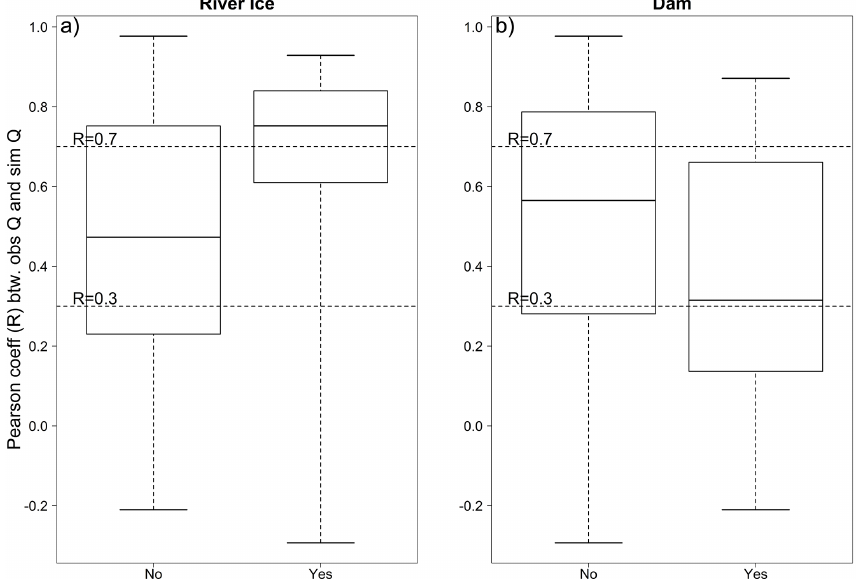
Figure 11. Evaluation of the R score obtained during the validation and its classification by (a) presence or absence of a river ice (Brown et al., 2002), and (b) presence or absence of a nearby dam or hydraulic control infrastructure using the Global Reservoir and Dam (GRanD) database (Lehner et al., 2008) and a visual check with Google Maps. For the validated locations, it is worth nothing that all stations with river ice (33) and most of them with dams (34 out of 48) are located in North